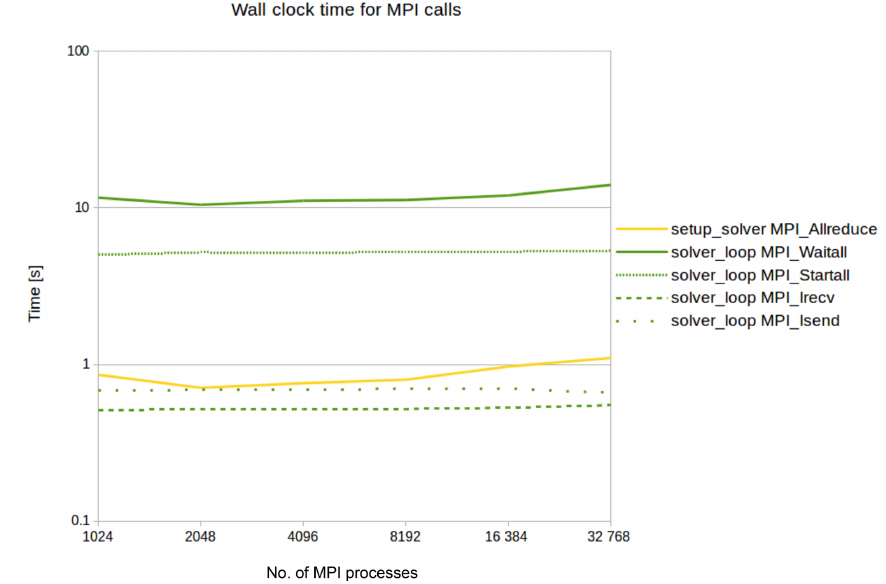
Figure 8. Wall clock time for MPI calls for the weak scaling experiment using the test case described in Sect.